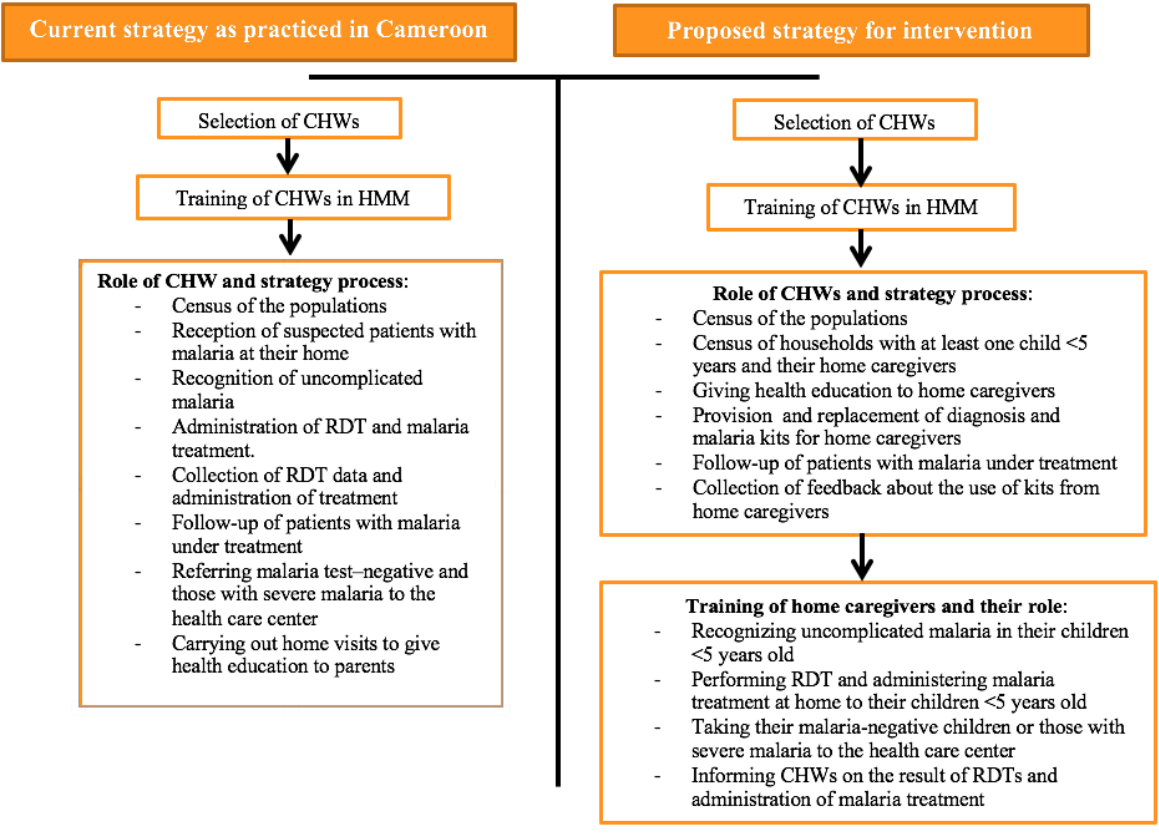
Figure 4. Flow chart of the two strategies. CHW: community health worker; HMM: home-based management of malaria; RDT: rapid diagnosis test.